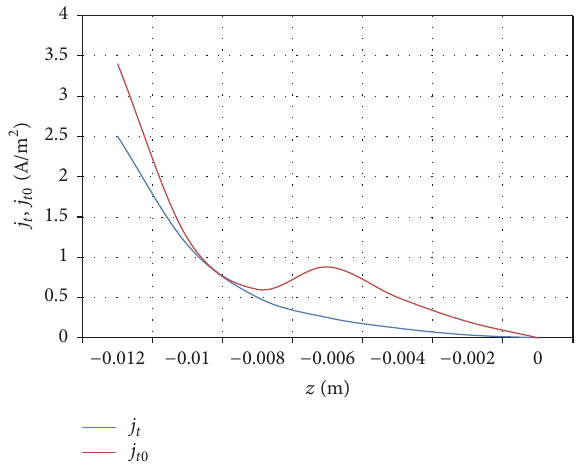
Figure 2: Distribution of the emission’s current densities in the penetration channel during excitation of a non-self-sustaining discharge: 𝑗 𝑡0 is the density of the thermionic current; 𝑗 𝑡 is the current density, accounting for the Schottky effect.